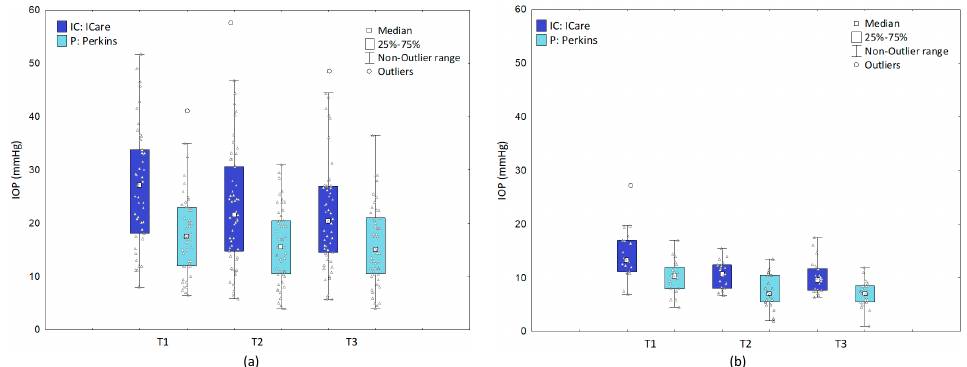
Figure 4. Median IOP at T1–T3 measured with iCare and Perkins ( a ) glaucoma subjects ( b ) healthy